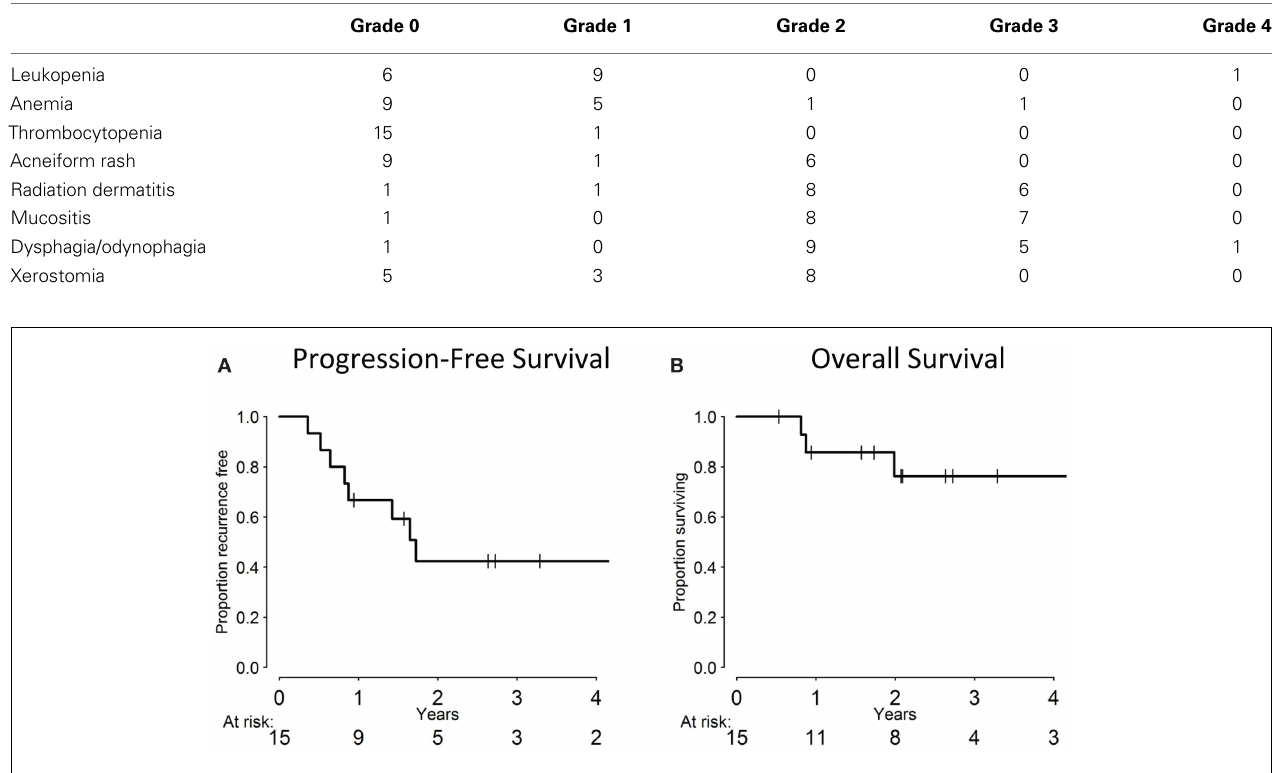
FIGURE 1 | Progression-free (A) and overall survival (B) of patient cohort